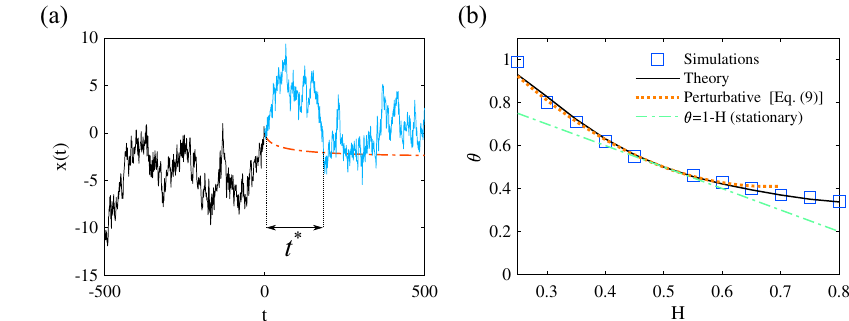
Fig.2|PersistenceforfBMconditionedonthepasttrajectory(typeIIproblem). a De fi nitionoftheproblem:assumethataparticulartrajectoryisobservedfor t <0 (black curve). The blue line isone realization of trajectory for t >0, the dashed red linerepresentstheaveragetrajectorygiventhatthepasttrajectoryisobserved.The time t * is the fi rst crossing time to this predicted average trajectory, and the